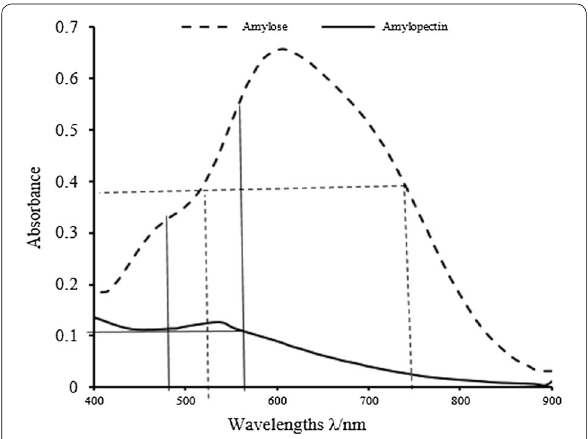
Fig. 1 The main wavelength and the particular wavelength for amylose were 554 and 490 nm and the main wavelength and the particular wavelength for amylopectin were 542 and 713